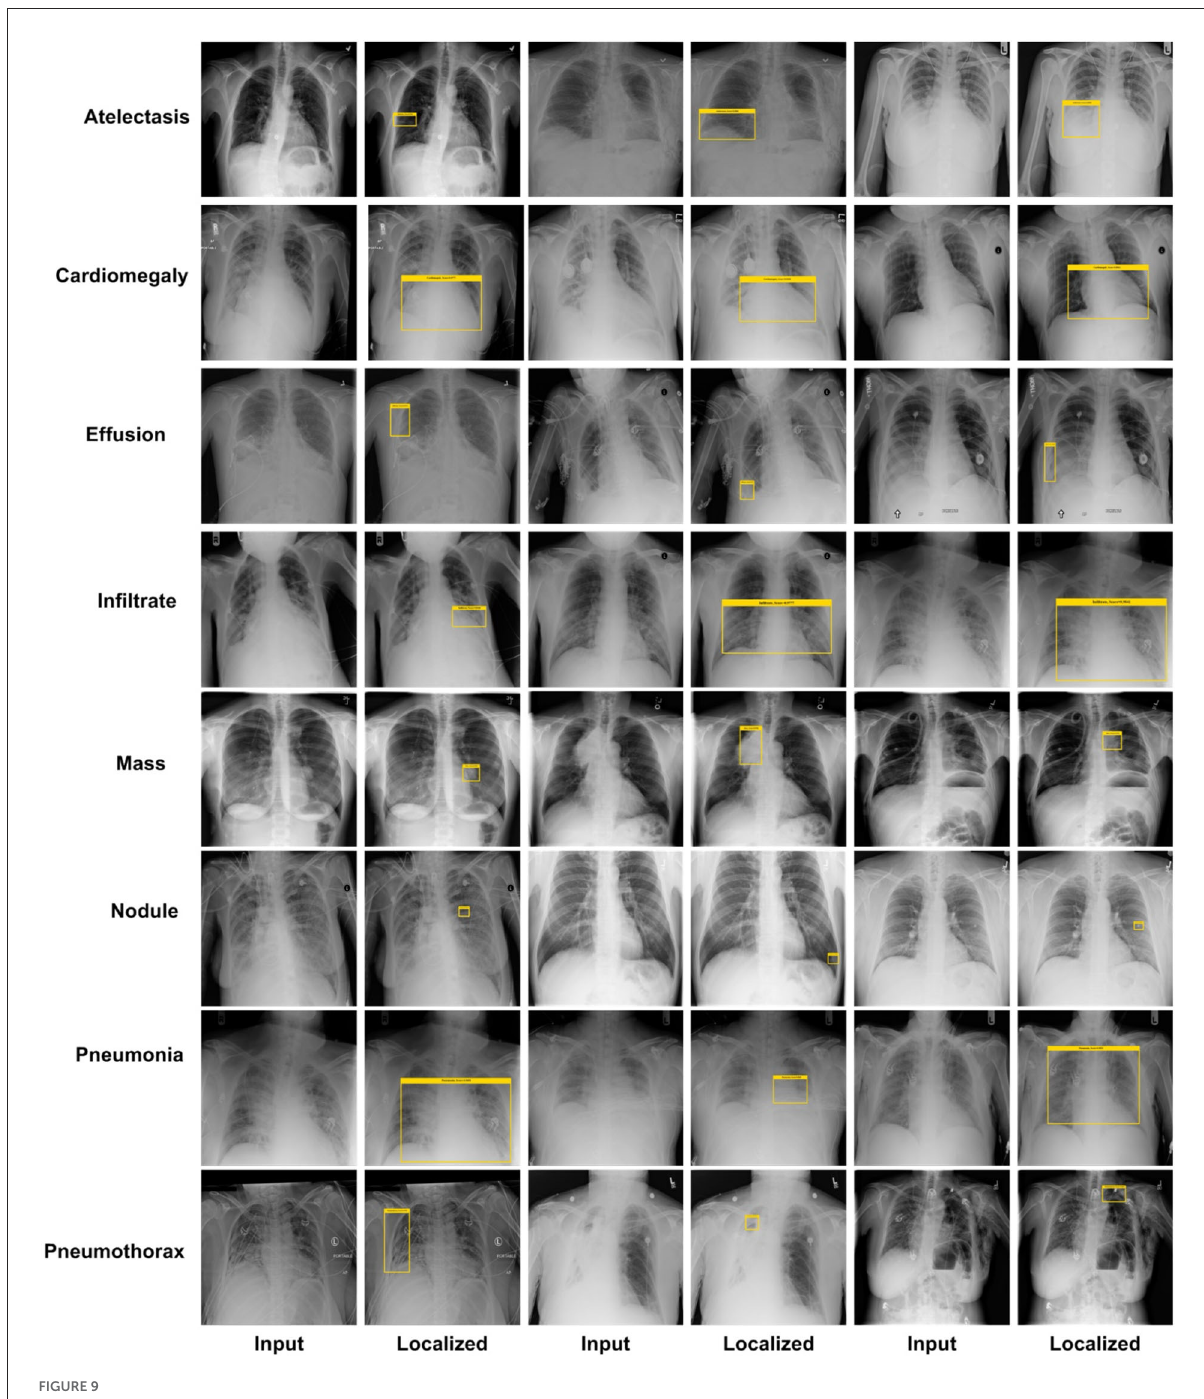
FIGURE9 Localization results of the proposed method.